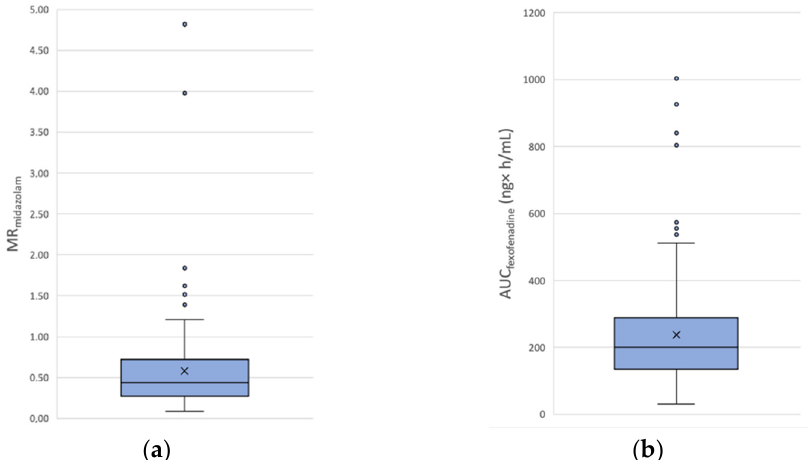
Figure 2. Distribution of phenotype metrics in the rivaroxaban cohort ( a ) MR midazolam and ( b ) AUC fexofenadine